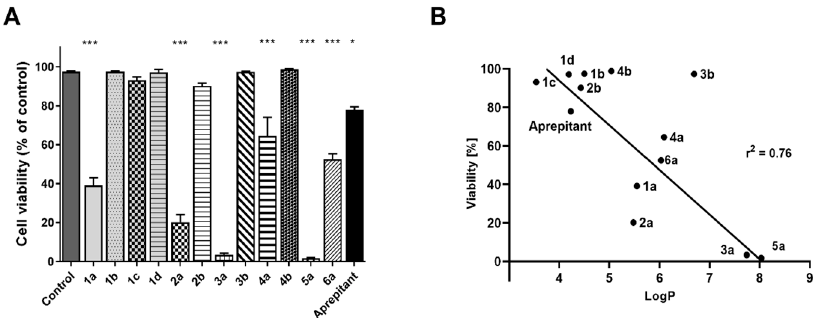
Figure 9. The results of cytotoxicity evaluation. ( A ) Viability of MeW155 cells after incubation with the tested compounds (as % of the control value). The results were analyzed with repeated measures one-way ANOVA followed by the Dunnett post-hoc test. Asterisks (*) indicate a significant difference compared to control. Note: * p < 0.033, and *** p < 0.001. ( B ) Correlation of melanoma cell line MeW155 viability (%) with the theoretical LogP value. Point 3b excluded from correlation.